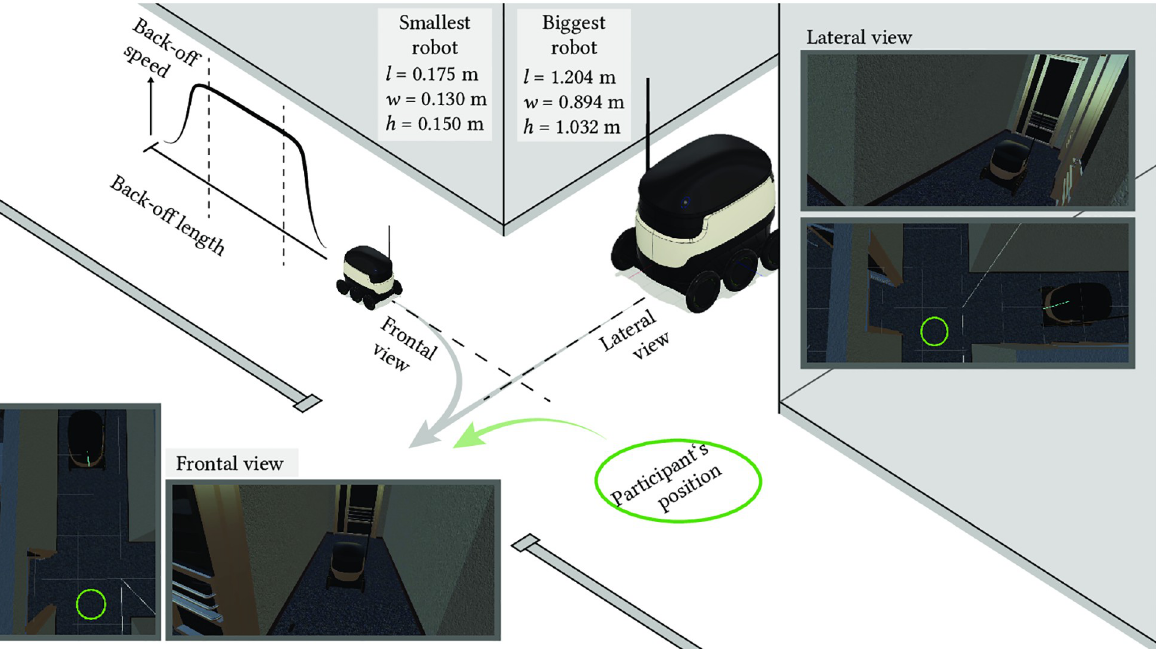
Fig 1. Illustration of the virtual study environment, the experimental conditions, and measures. Robots with different sizes ranging from 0.175 m x 0.130 m x 0.150 m to 1.204 m x 0.894 m x 1.032 m (length x width x height) were manipulated from two viewpoints, the frontal view and the lateral view. In a training phase, participant and robot moved through a door and the robot performed a predefined back-off (arrows represent approximations to the planned paths). In the design phase of the experiment, participants adjusted the back-off length and back-off speed of the robot from a stationary position (participant’s